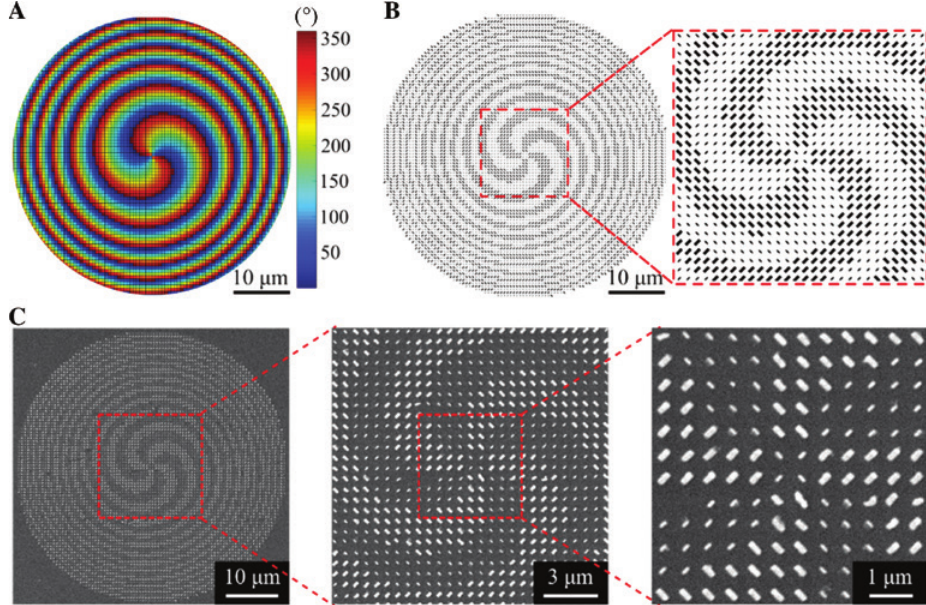
Figure 3: Design and fabrication of the focused vortex-beam generator with a diameter of D = 50 μ m, a focal length of f = 60 μ m, and the = 850 topological charge of l = 2 at λ d